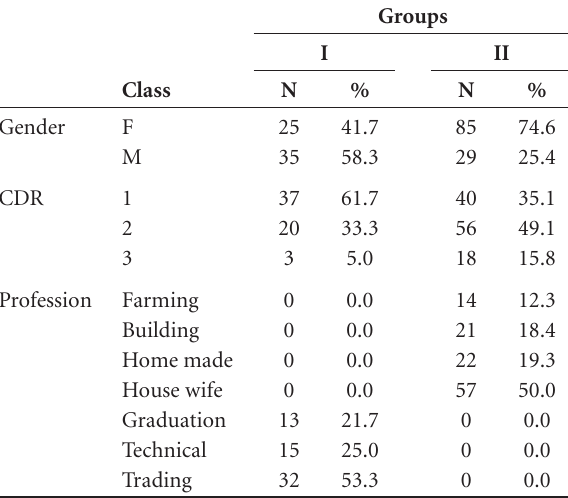
Table 1. Distribution according to gender, CDR and previous occupation.